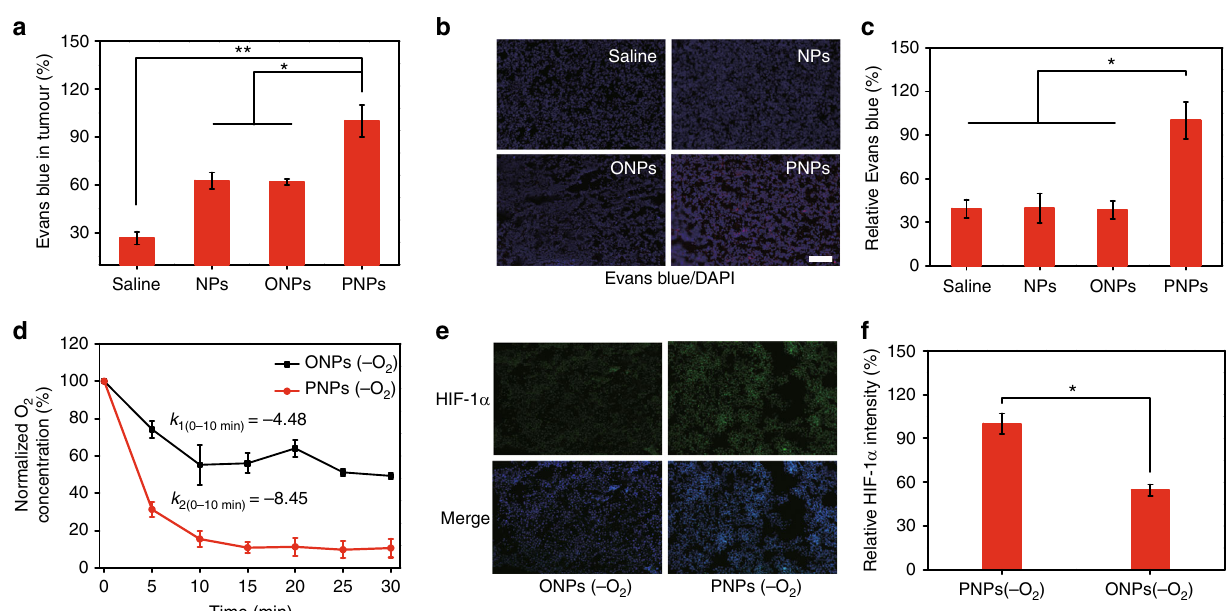
Fig. 2 Long-term effects of enhanced permeability and hypoxia mediated by deoxygenated PNPs in vivo. a Analysis of Evans blue accumulation in tumours 24 h after the intravenous injection of deoxygenated PNPs. Evans blue in the whole tumour was extracted and quanti fi ed by ultraviolet – visible (UV – vis) spectroscopy ( n = 3). b Ex vivo fl uorescence images of Evans blue (red) and 4 ′ ,6-diamidino-2-phenylindole (DAPI) (blue) staining (scale bar, 100 µ m). c Quanti fi cation of Evans blue accumulation in b ( n = 3). d Changes in DO after the intratumoural injection of deoxygenated PNPs and oil nanoparticles (ONPs). e Representative immuno fl uorescence images of hypoxia-inducible factor-1 α (HIF-1 α ) (green) staining at 24 h after the intratumoural injection of deoxygenated PNPs and ONPs (scale bar, 100 µ m). f Quanti fi cation of HIF-1 α expression shown in e ( n = 4). Data are presented as the mean ± s.e.m. * p < 0.05, ** p < 0.01 (unpaired, two-way t tests). Source data are provided as a Source Data fi